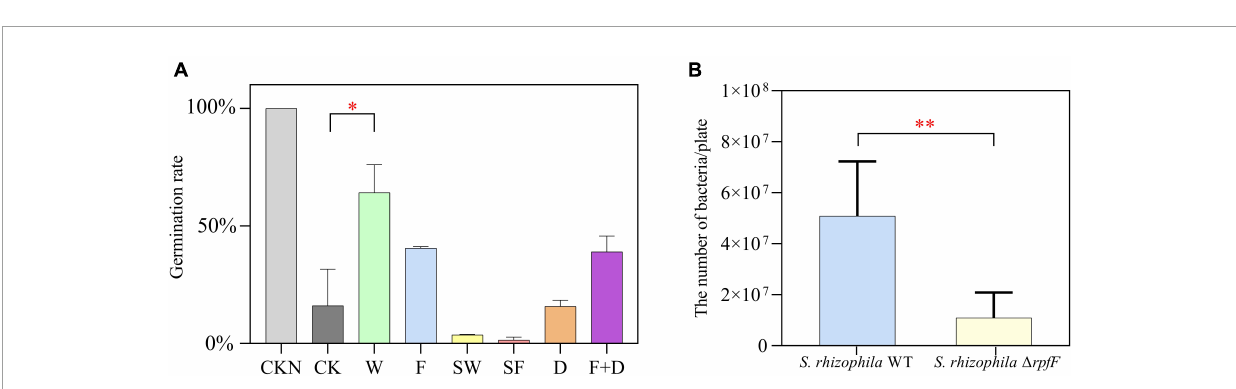
FIGURE4 (A) Comparison of germination percentage of CKN, CK, W, F, SW, SF, and D groups, bar. Error bars indicate ± SD, n = 9 (ANOVA, followed by the Tukey’s HSD test, ∗ P < 0.05). (B) Comparison of bacterial counts between W and F groups. Error bars indicate ± SD, n = 3 (Welch’s t test, ∗∗ P <